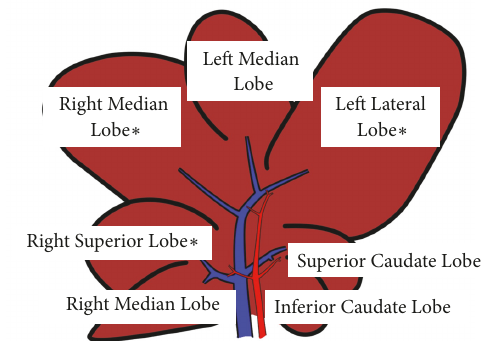
Figure 1: Graphic (schematic)representation of hepatic lobes. Liver samples were collected ( ∗ ) from superior right lobe (RL), right median lobe (ML), and lateral left lobe